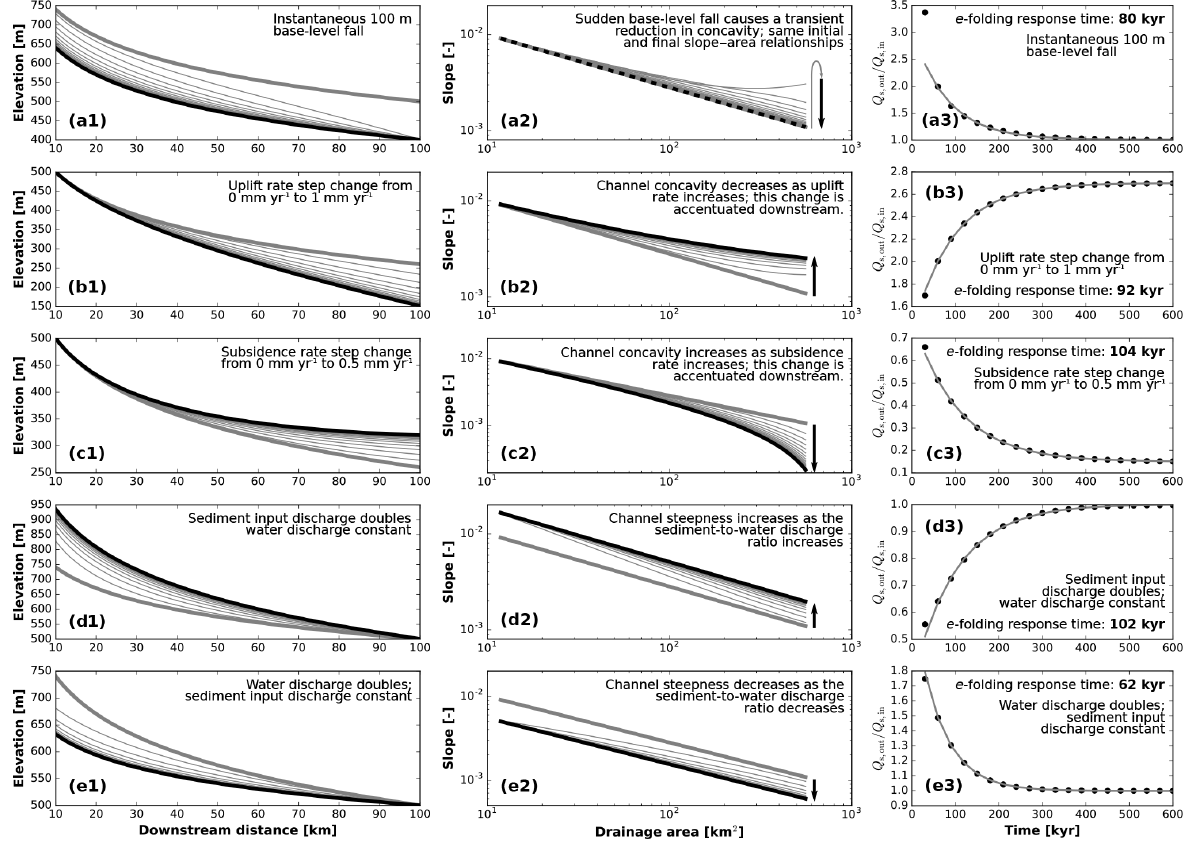
Figure 6. Transient long profiles from numerical model runs and their response times to external forcings. Each fine gray line in panel sets 1 and 2, corresponding to black dots on panel set 3, represents 30000 years with an intermittency of I = 1 (i.e., constant geomorphically effec- tive discharge conditions). Thick gray lines on panel sets 1 and 2 are the initial long profile; thick black lines are the final long profile. In the slope–area plots (panel set 2), the slope of the line is the negative of the concavity index and the y intercept is the normalized steepness index (Whipple and Tucker, 1999). Transient response times (right) are quantified by the ratio of catchment-wide sediment input ( Q s , in ) to output sediment discharge ( Q s , out ). We quantify response times using exponential decay functions and e -folding timescales, but note that this does not describe the changes in sediment discharge immediately following the perturbation. All base-level changes are purely vertical, and can consequently represent steeply dipping faults or sea-level change across a steep coastline. Base model boundary conditions and parameters are as follows: S 0 = 0 . 01; 10km ≤ x ≤ 100km; Q = 1 . 43 × 10 − 5 x 49 / 40 m 3 s − 1 ; A = x 7 / 4 m 2 ; and B = 79 . 06 x 1 / 10 m. (a) An instantaneous 100m base-level fall causes a transient response and a sudden increase in sediment output but eventually produces the same channel long profile, albeit translated downward. (b) The onset of 1mmyr − 1 steady base-level fall (or tectonic uplift) reduces channel concavity; this allows the river to transport the additional bed-derived sediment as it incises and causes sediment output to rise as a result. (c) The onset of 0.5mmyr − 1 steady base-level rise (or subsidence) increases concavity due to increasing deposition rates that are required to fill the accom- modation space created, and reduces sediment output accordingly. (d) Doubling the input sediment discharge ( Q s ), facilitated by adjusting 0 S 0 according to Eq. (18), increases channel steepness proportionally (Eq. 54); this increase in steepness propagates downstream and gradu- ally leads to an increase in output sediment discharge. (e) Doubling the water discharge ( Q ) decreases channel steepness proportionally; this decrease in steepness propagates downstream more rapidly than that due to doubling sediment input because an increase in water discharge increases sediment-transport capacity; output sediment discharge increases until the slope decreases, returning sediment output to its initial